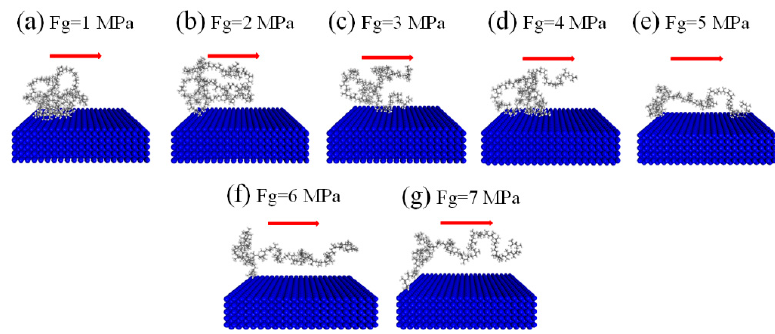
Figure 9. Change in the PMMA molecular chain morphology near the wall under different external pressures.